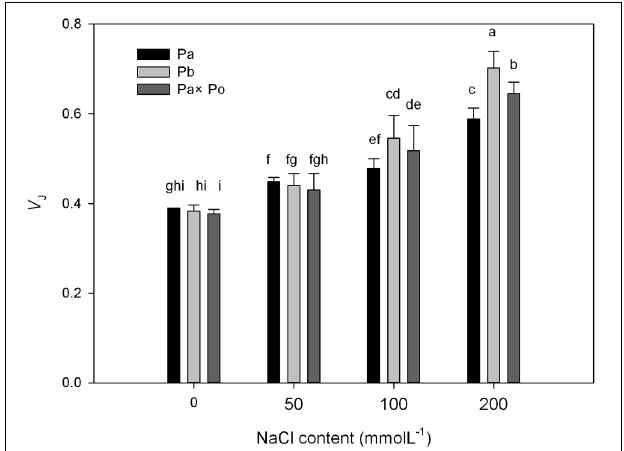
FIGURE 5 | The effect of salt stress on the standardized OJIP curves and V J of leaves of three P. amurensis . Pa, P. amurensis Maxim ( “Diabolo” ( ); Pa × Po, P. amurensis Maxim ( Data in the figure are mean ± SE; values followed by different lowercase ♂ letters indicate a significant difference ( p < 0.05).